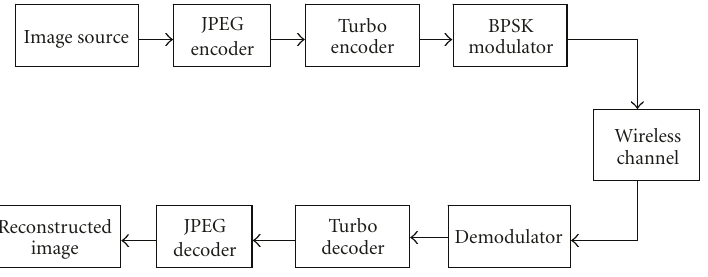
Figure 9: Image transmission system using typical and proposed turbo codes.